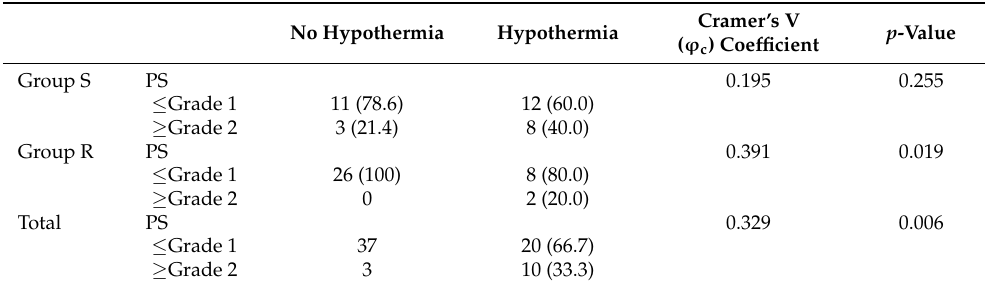
Table 4. The association between the severity of PS requiring treatment with meperidine and the incidence of